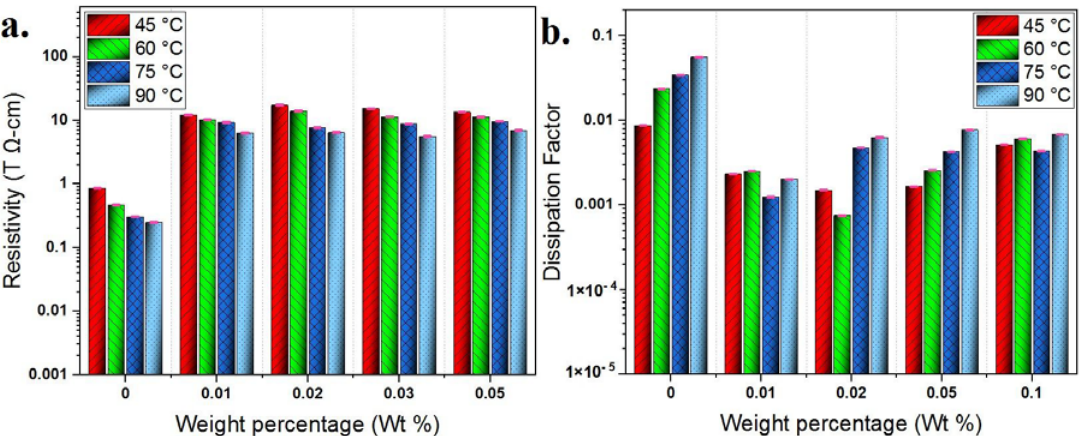
Figure 8. Variation of ( a ) resistivity and ( b ) dissipation factor against weight percentage at various Figure8. Variationof( a )resistivityand( b temperatures.